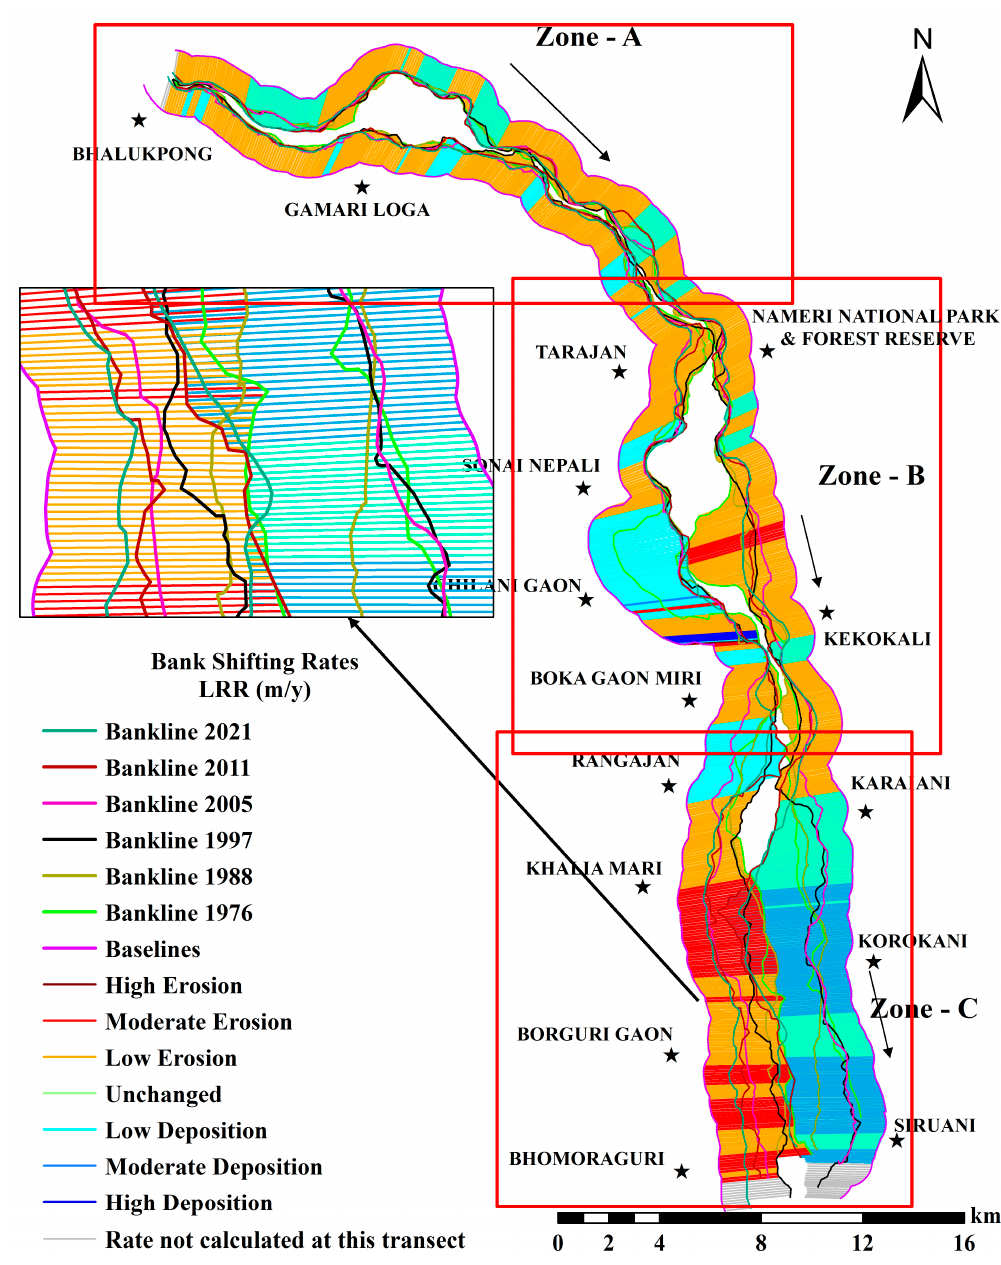
Figure 6. LRR-based channel migration rate (erosion and deposition) during the periods of 1976 to 2021. From 1997 to 2005, the average shifting rates in the right and left banks of zone A, B, and C were − 17.76 and − 6.06, − 42.61 and − 32.16, and − 123.38 and − 21.25 m/y, respectively. The average rates of deposition and erosion in the right and left banks were − 65.11 and − 26.87 m/y and 7.47 and 18.59 m/y, respectively. Right bank shifting averaged − 61.81 m/y, whereas left bank shifting averaged − 19.85 m/y over this time period (Tables 3 and 4). Thus, erosion processes were more active during 1997 to 2005 at both banks (Figures 4 and 5), with rates comparatively higher on the right